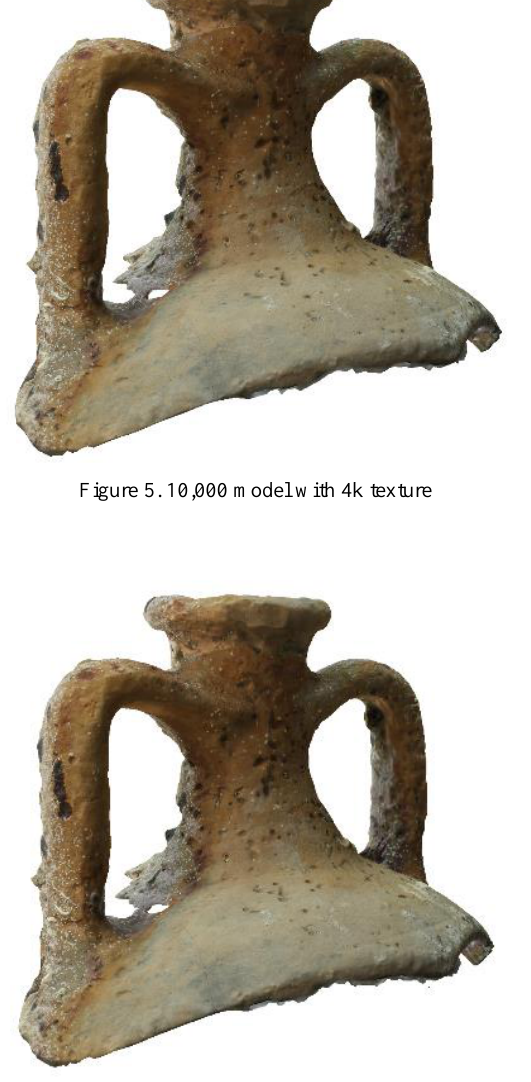
Figure 6. 100,000 model with 8k texture